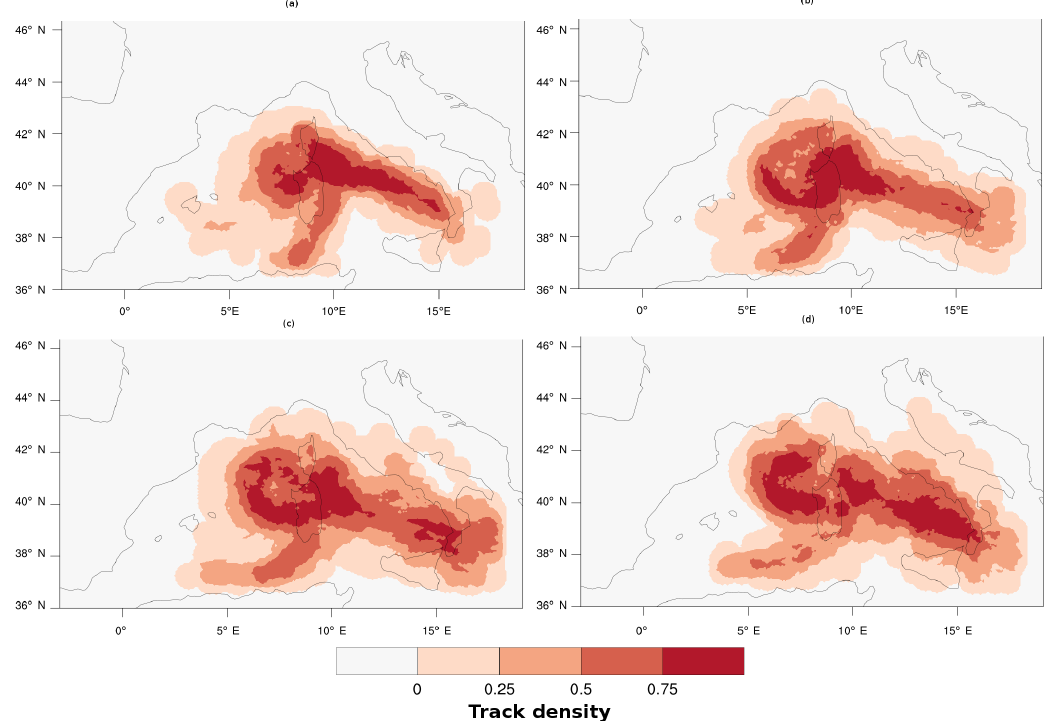
Figure 3. Track densities based on all cyclones for an SST change of (a) − 3K, (b) 0K (original SSTs), (c) + 3K and (d) +